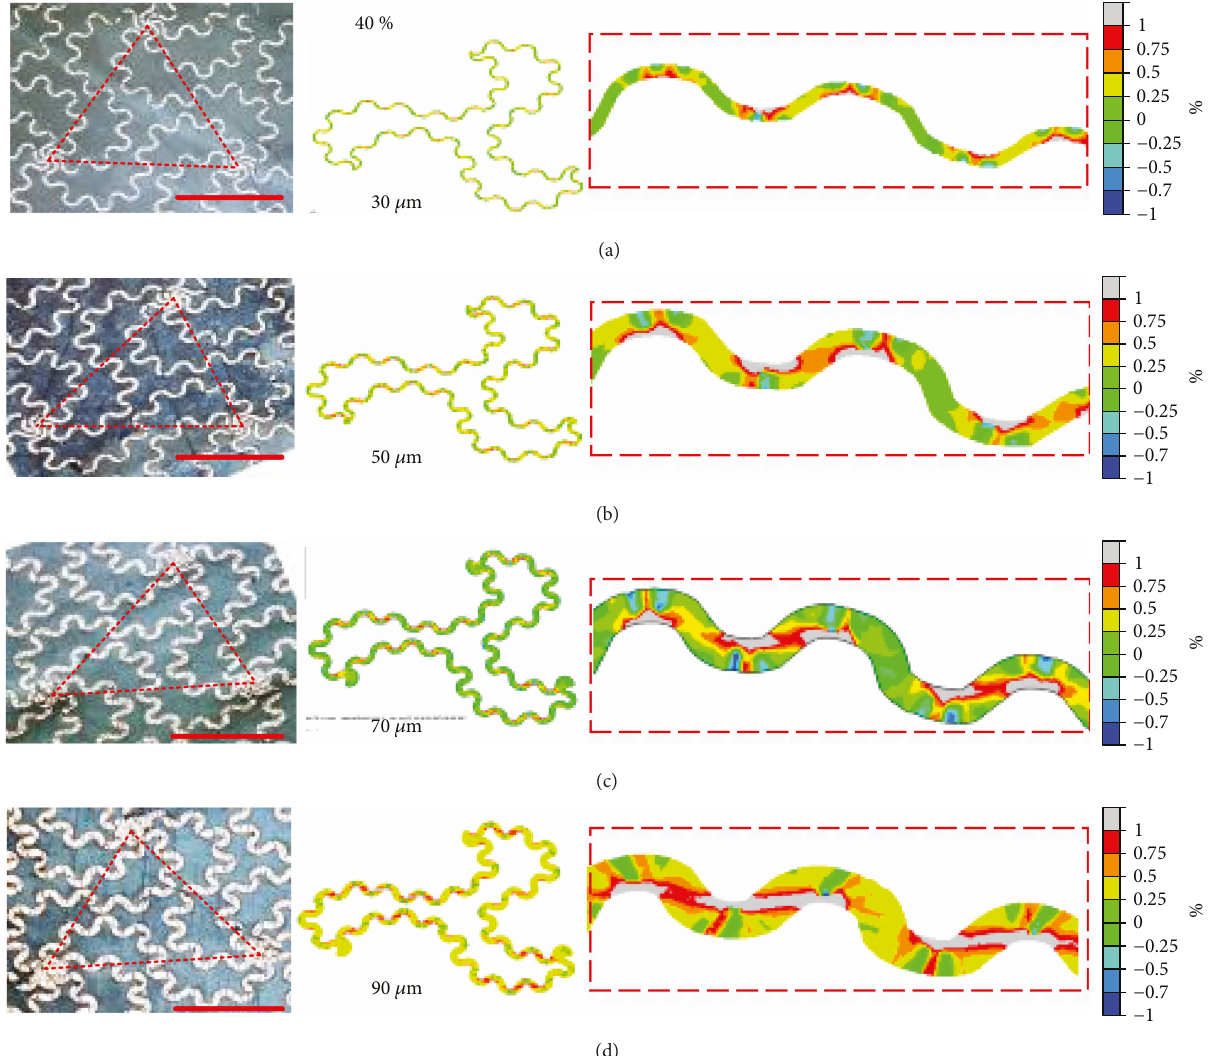
Figure 6: Experimental and FEM simulation results with di ff erent widths in 40% stretched format: (a) 30 μ m, (b) 50 μ m, (c) 70 μ m, and (d) 90 μ